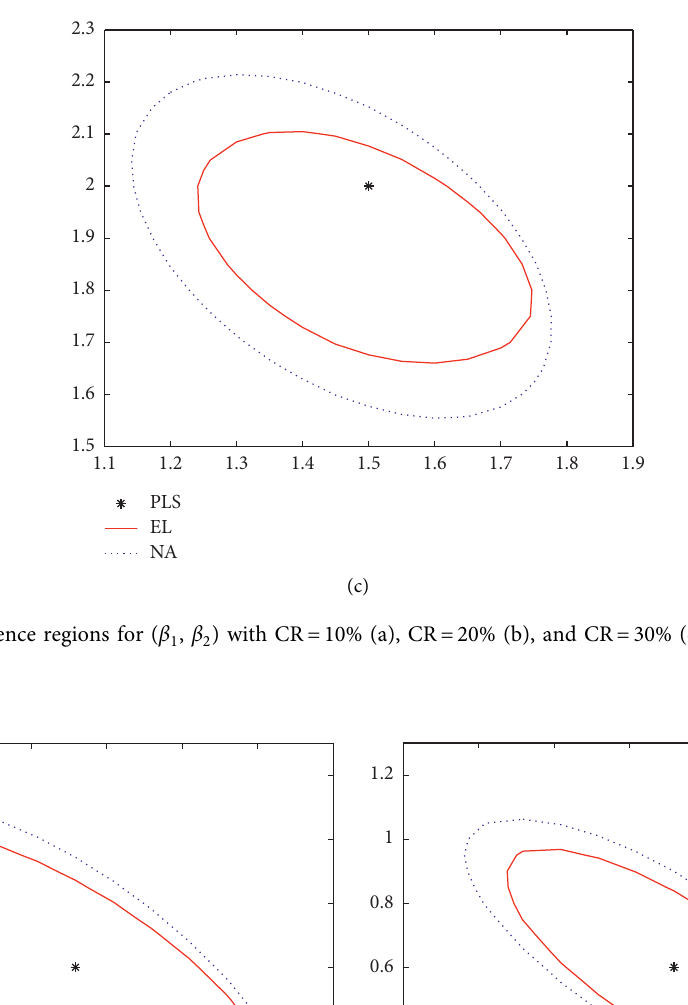
, θ ) based on EL and NA methods with nominal level 1 − α � 0 . 95 (a) and 0.90 (b), respectively. 1 2